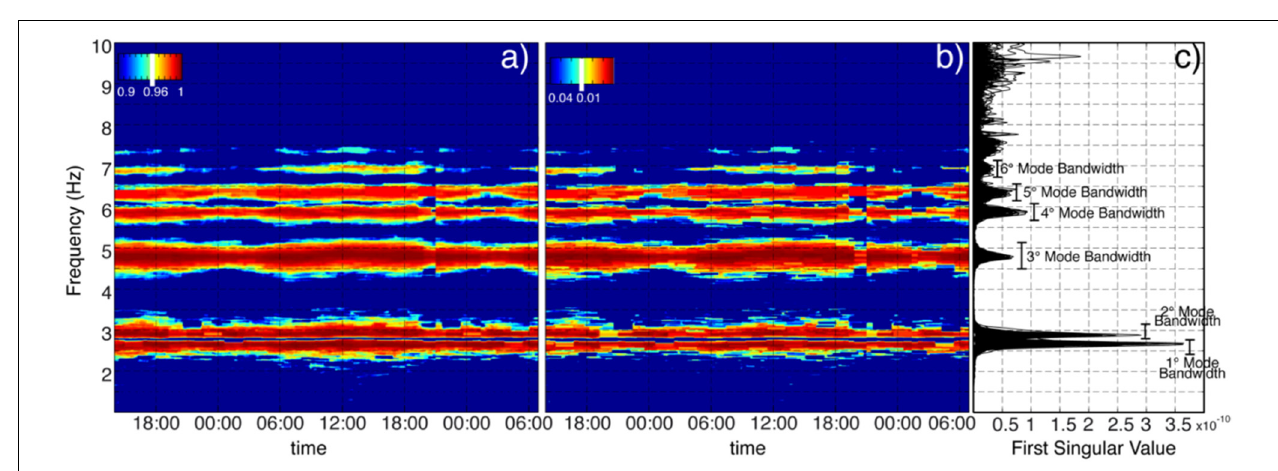
Frontiers in Built Environment |